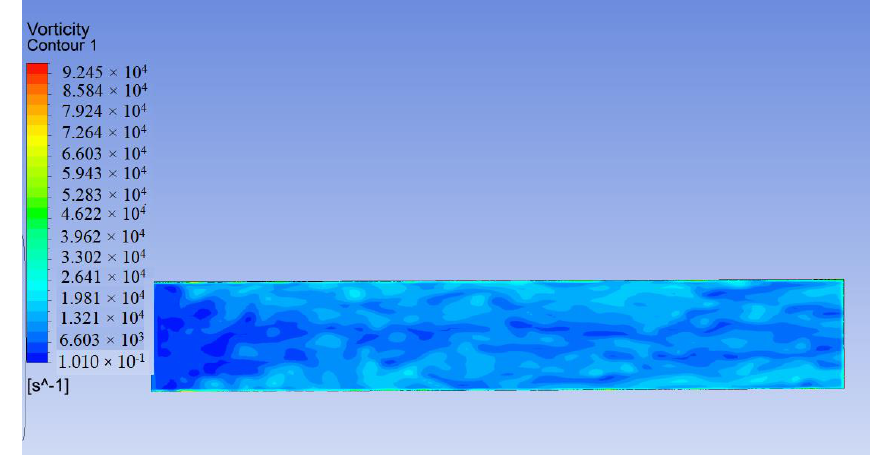
Figure 4. Vorticity cloud image of PVDF film.